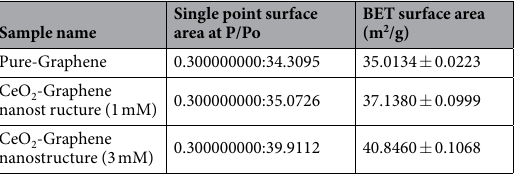
Applications of the 1 mM and 3 mM CeO -Graphene nanostructures 2 Evaluation of the photocatalytic degradation of organic model pollutant dyes (CR and MB) using pure-graphene, 1 mM and 3 mM CeO -Graphene nanostructures. Metal oxide NPs is a sig- 2 nificant reagent used in the pharmaceutical and biochemical industries, whereas different kinds of organic dyes, such as CR and MB, are anionic and cationic hetero polyaromatic model dyes commonly used in the cellulose (textiles) industries (cotton textile, wood pulp, and paper) 46 . The anionic, cationic CR and MB dyes are used widely in a range of fields but their discharge into water can cause environmental pollution. In addition, most of the organic dyes are toxic, carcinogenic, and harmful, resulting in adverse impacts on human and animal health. Towards the better understanding of the significance of this photocatalyst system, the role of a photocatalyst is to accelerate the specific reduction and oxidation (redox) reactions under the visible light illuminated semi- conductors 18 . When the semiconductor catalyst was exposed with photons, whose energy is equal to or greater than their band-gap energy (E g ), an electron (e-cb) is promoted from the valence band (VB) into the conduction band (CB), leaving a hole (h + -vb) 19 . Furthermore, the excited electrons and holes transfer to the surface. The rate of recombination is often inhibited by a scavenger or crystalline surface defects, which can easily trap elec- trons or holes. Therefore, better crystallinity with surface defects can generally decrease the trapping states and recombination sites, subsequent in increased effectiveness in the procedure of the photogenerated carriers for the preferred photoreactions 46 . For higher photocatalytic efficiency, the electron–hole pairs should be separated